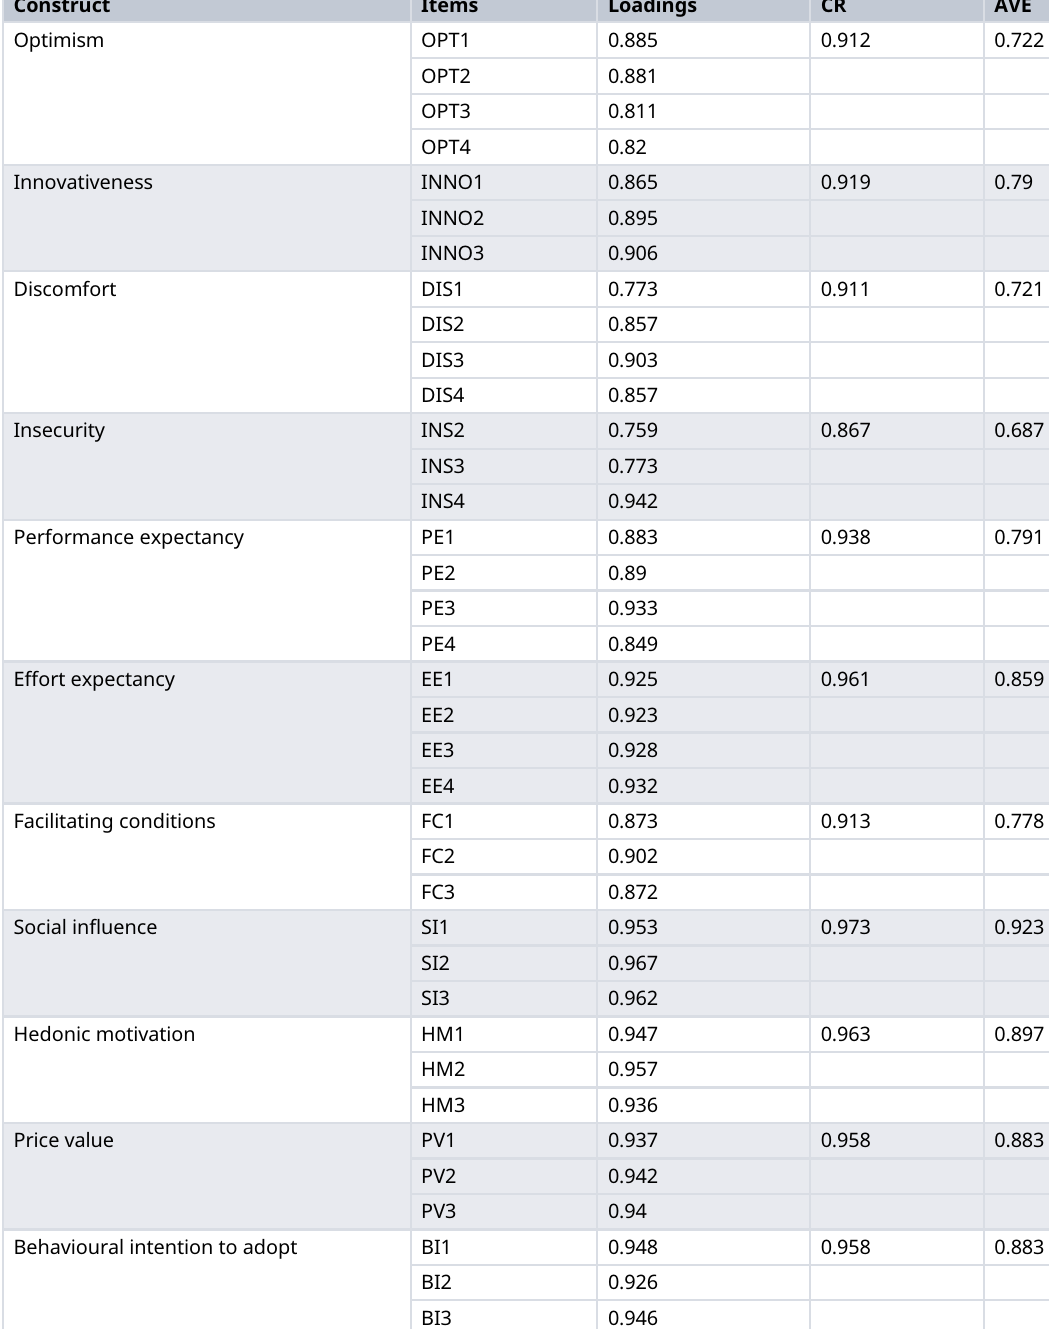
Table 1. Measurement model